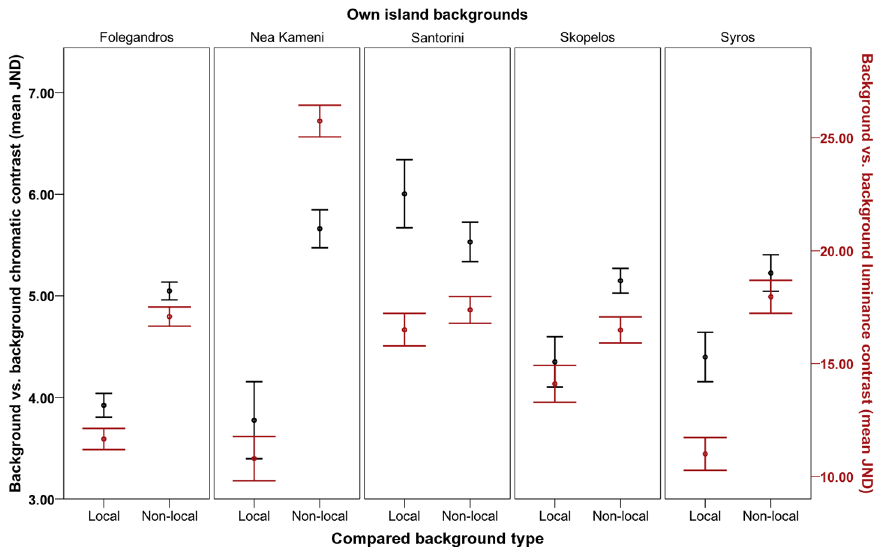
Fig 3. Degree of rock background contrast between islands. Degree of contrast refers to how different Aegean wall lizard ( Podarcis erhardii ) rock backgrounds are to that of their local island population relative to how different they are to the backgrounds of other (non-local) island populations overall (Folegandros, Nea Kameni, Santorini, Skopelos and Syros) in terms of chromatic contrast (left axis; black data points) and luminance contrast (right axis; red data points) (mean JND). JND values increasing > 3.00 depict rock backgrounds that are progressively distinguishable by avian predators. Error bars represent +/- 1 S.E.